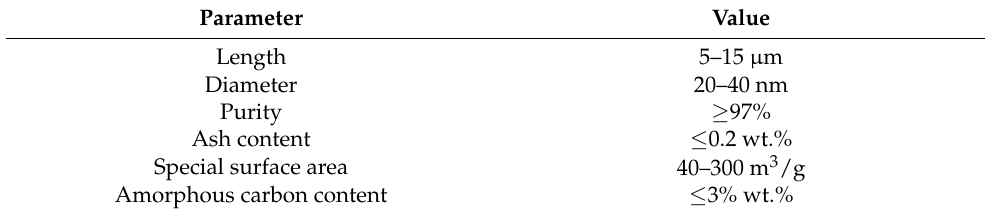
Table 1. Main characteristics of multi-walled carbon nanotubes (MWCNTs).